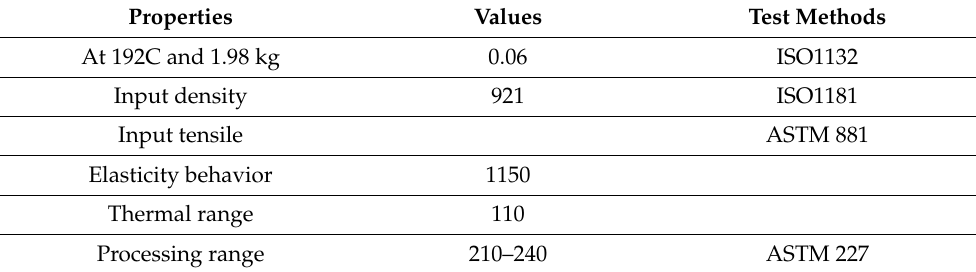
Table 3. Properties of